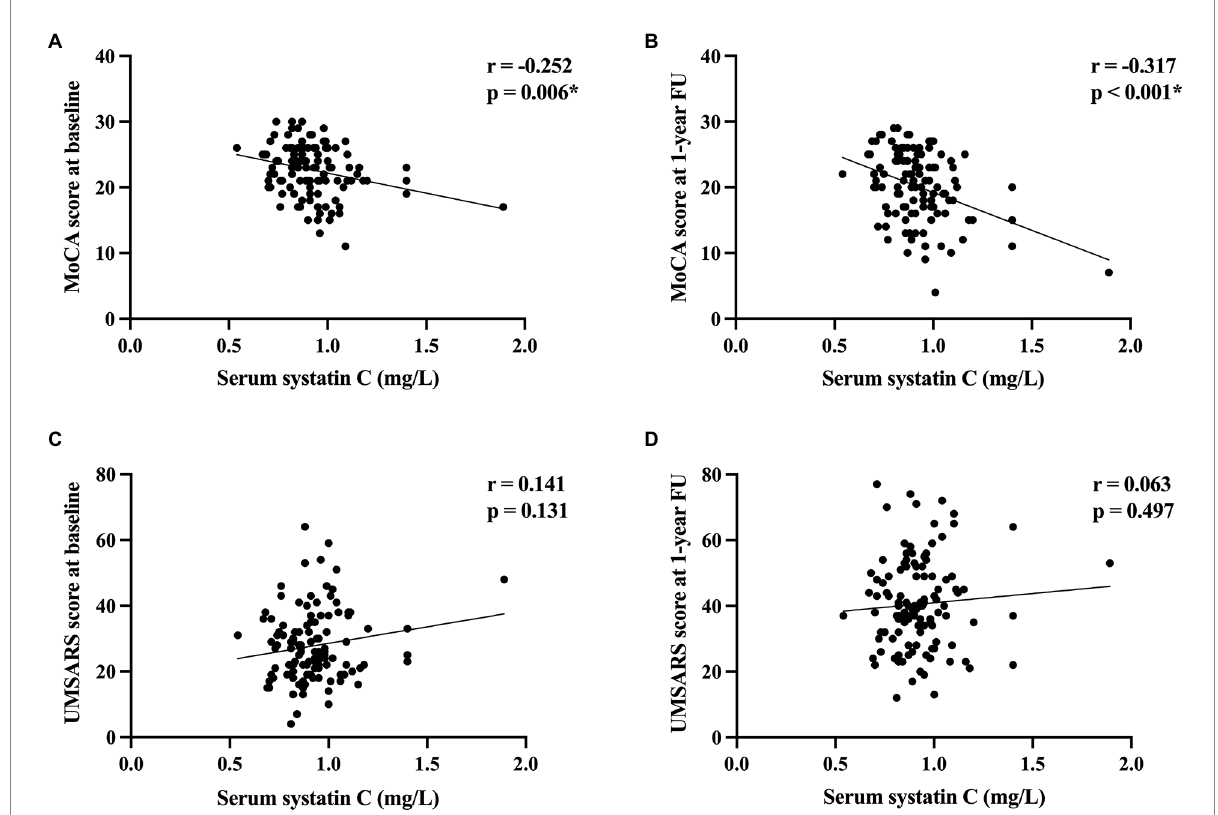
FIGURE 3 The correlation between cystatin C levels and cognitive function and disease severity in patients with MSA. (A) The correlation between cystatin C levels and MoCA score at baseline. (B) The correlation between cystatin C levels and MoCA score at 1-year follow-up. (C) The correlation between cystatin C levels and UMSARA score at baseline. (D) The correlation between cystatin C levels and UMSARS score at 1-year follow-up. *Significant difference.